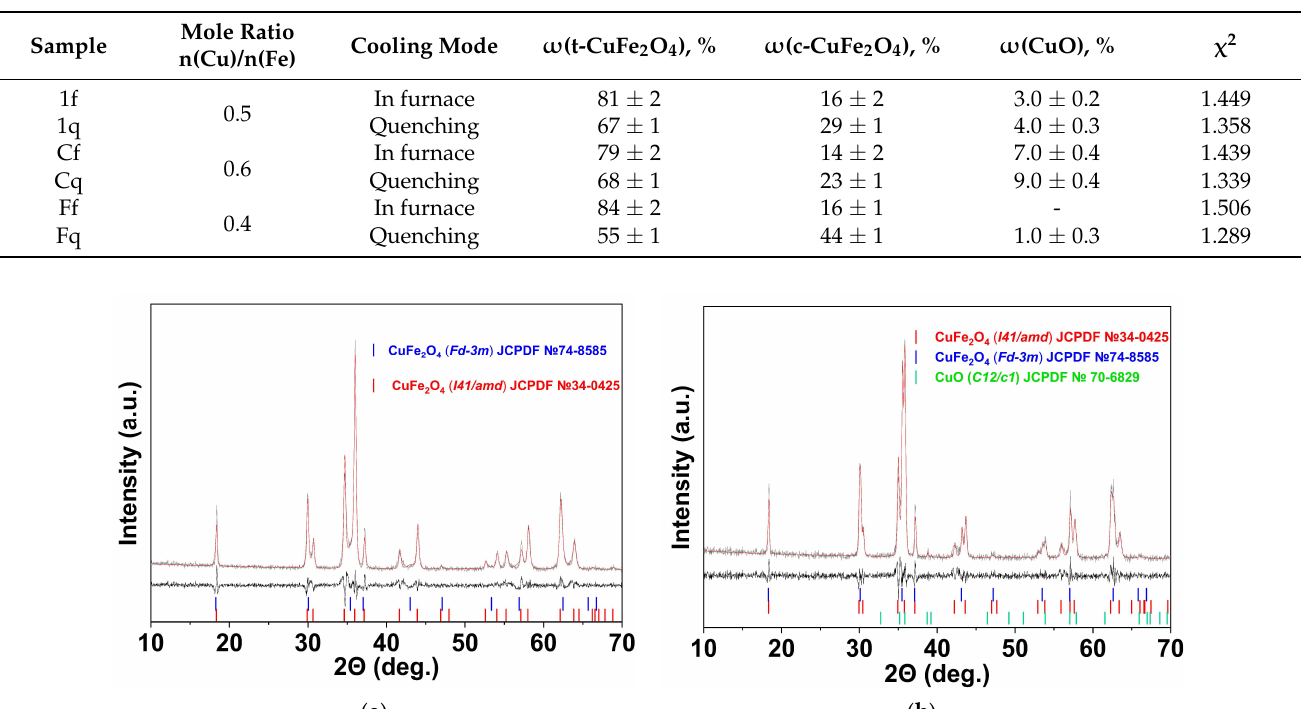
Table 4. Phase composition of the samples with different mole ratios of Cu to Fe annealed at 900 ◦ C and cooled at various rates.